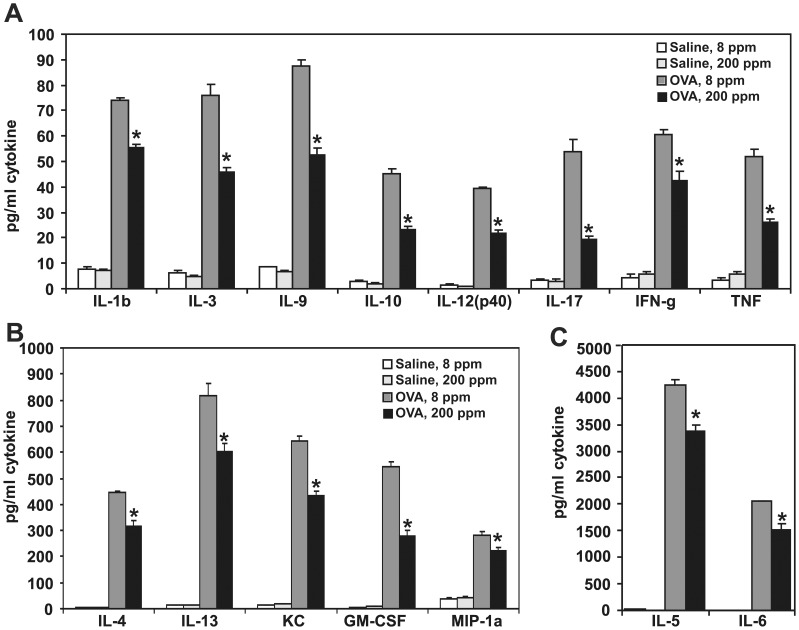
Effects of iron supplementation on allergen-induced cytokine secretion into bronchoalveolar spaces.Cytokine and chemokines present in bronchoalveolar lavage (BAL) fluid obtained from OVA-sensitized mice 24 hrs following the 3d challenge with aerosolized antigen or saline were markedly increased in unsupplemented compared with iron-supplemented mice (*indicate p<0.01). The percentage increase ranged from 25–35% for IL-1β, IL-5, IL-6, and IL-13 to 170% for IL-17.